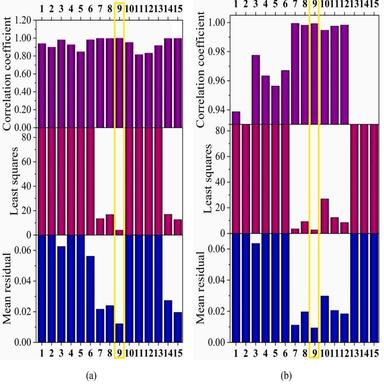
Comparisons of parameter evaluation among various kinetic models of energetic ionic salts 2 and 3. (The yellow boxes indicate the optimal model referred to as "n-th Prout-Tompkins equation with self-activation".).